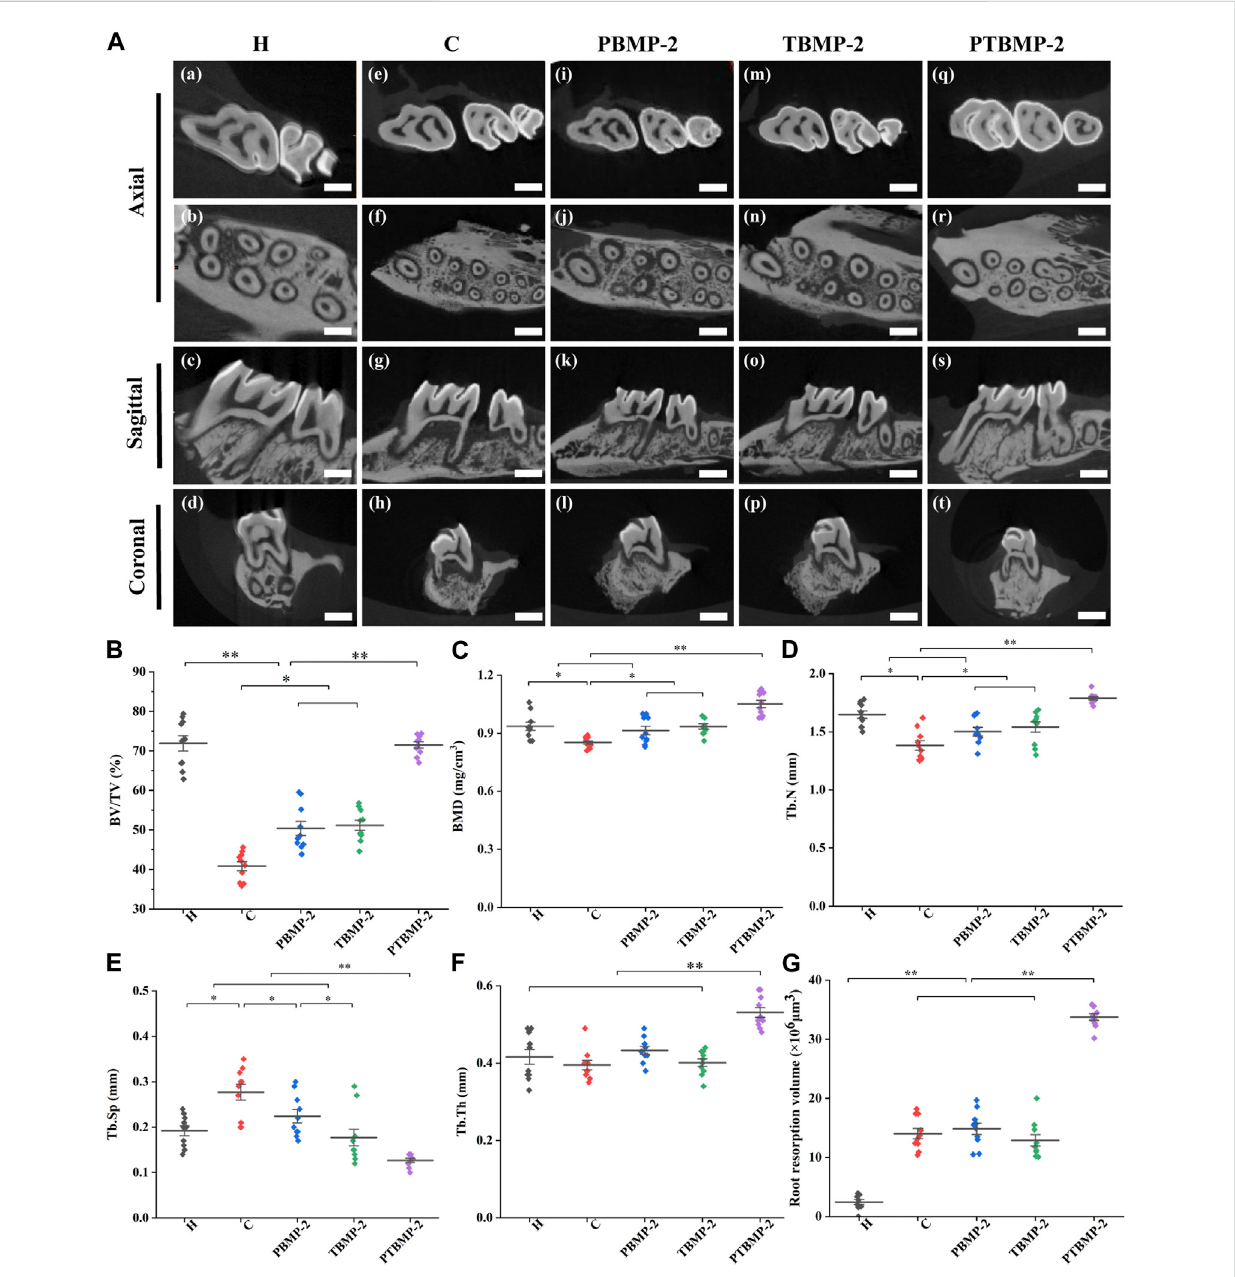
FIGURE 5 Bone remodeling observation in three dimensions of micro-CT, scale bar = 1000 μ m (A) . Micro-CT measurement of the microarchitecture parametersintheselectedROIofthemaxillary fi rstmolars:BV/TV (B) ,BMD (C) ,Tb.N (D) ,Tb.Sp (E) ,Tb.Th (F) .Rootresorptionvolumeofthemesialrootof M1 cementum surface using Convex Hull algorithm (G) . Data are presented as mean and standard deviation. *Signi fi cant ( p < 0.05) difference between groups, **Signi fi cant ( p < 0.01) difference between